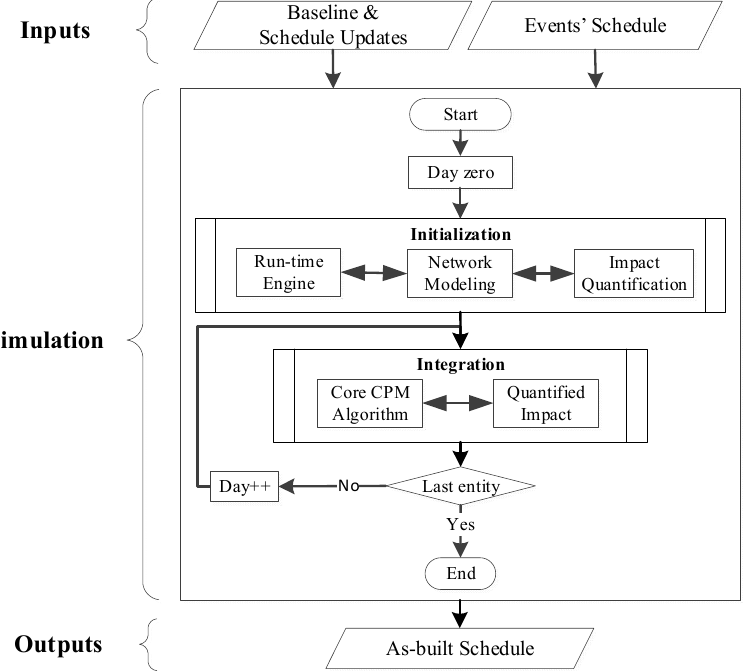
Figure 1. High-level Simulation Architecture.